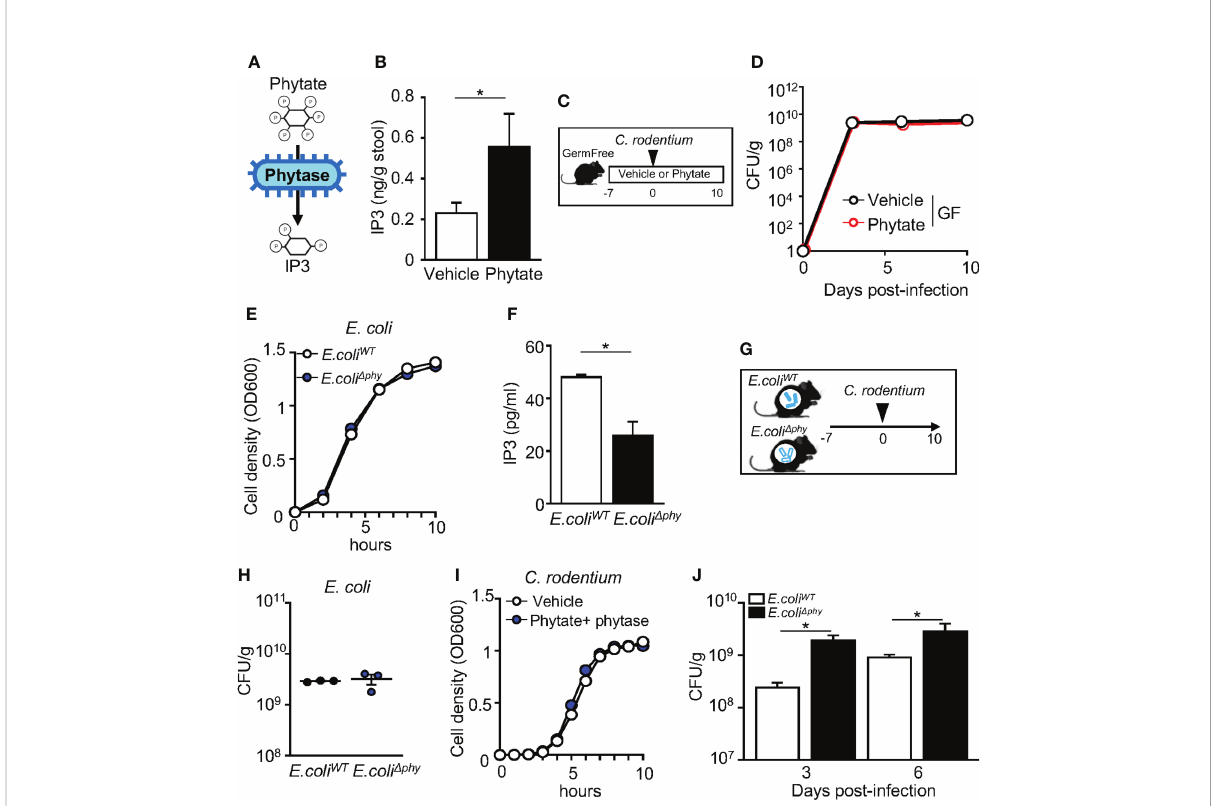
FIGURE 3 Metabolism of phytate by commensal bacteria mediates protection against infection. (A) Schematic of phytate metabolism by microbial phytase. (B) Inositol trisphosphate (IP3) concentration in fecal samples collected from vehicle- or 2% phytate-treated mice, normalized to sample weight. (C) Experimental approach. (D) CFUs of C. rodentium in stool of infected vehicle- or 2% phytate-treated GF mice, normalized to sample weight, days 3, 6 and 10 post-infection. (E) Bacterial cell density of E. coli . (F) IP3 concentration in media from E. coli WT and E. coli D phy cultured with 1mM phytate, per 10 8 CFU of bacteria. (G) Experimental approach. (H) CFUs of E. coli in stool of monoassociated mice, normalized to sample weight, day 7 post-inoculation. (I) Bacterial cell density of C. rodentium . (J) CFUs of C. rodentium in stool of infected mice monoassociated with E. coli WT or E. coli D phy , normalized to sample weight, days 3 and 6 post-infection. Data are representative of 2-3 independent experiments. n = 3-4 per group. Results are ± SEM. * p <